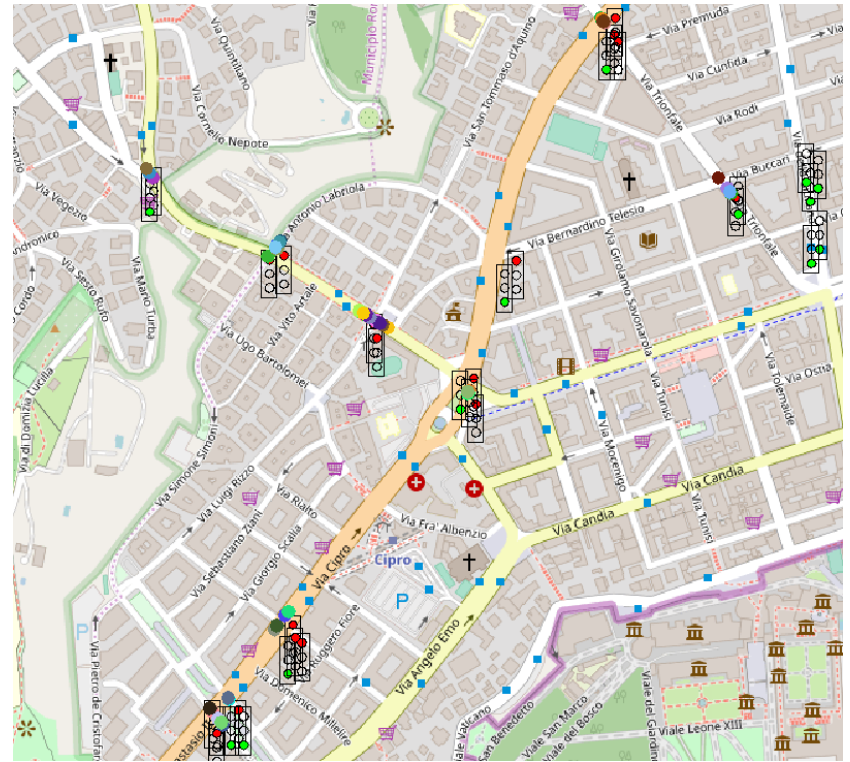
Figure 14. Sim2Car screenshot for traffic conditions in